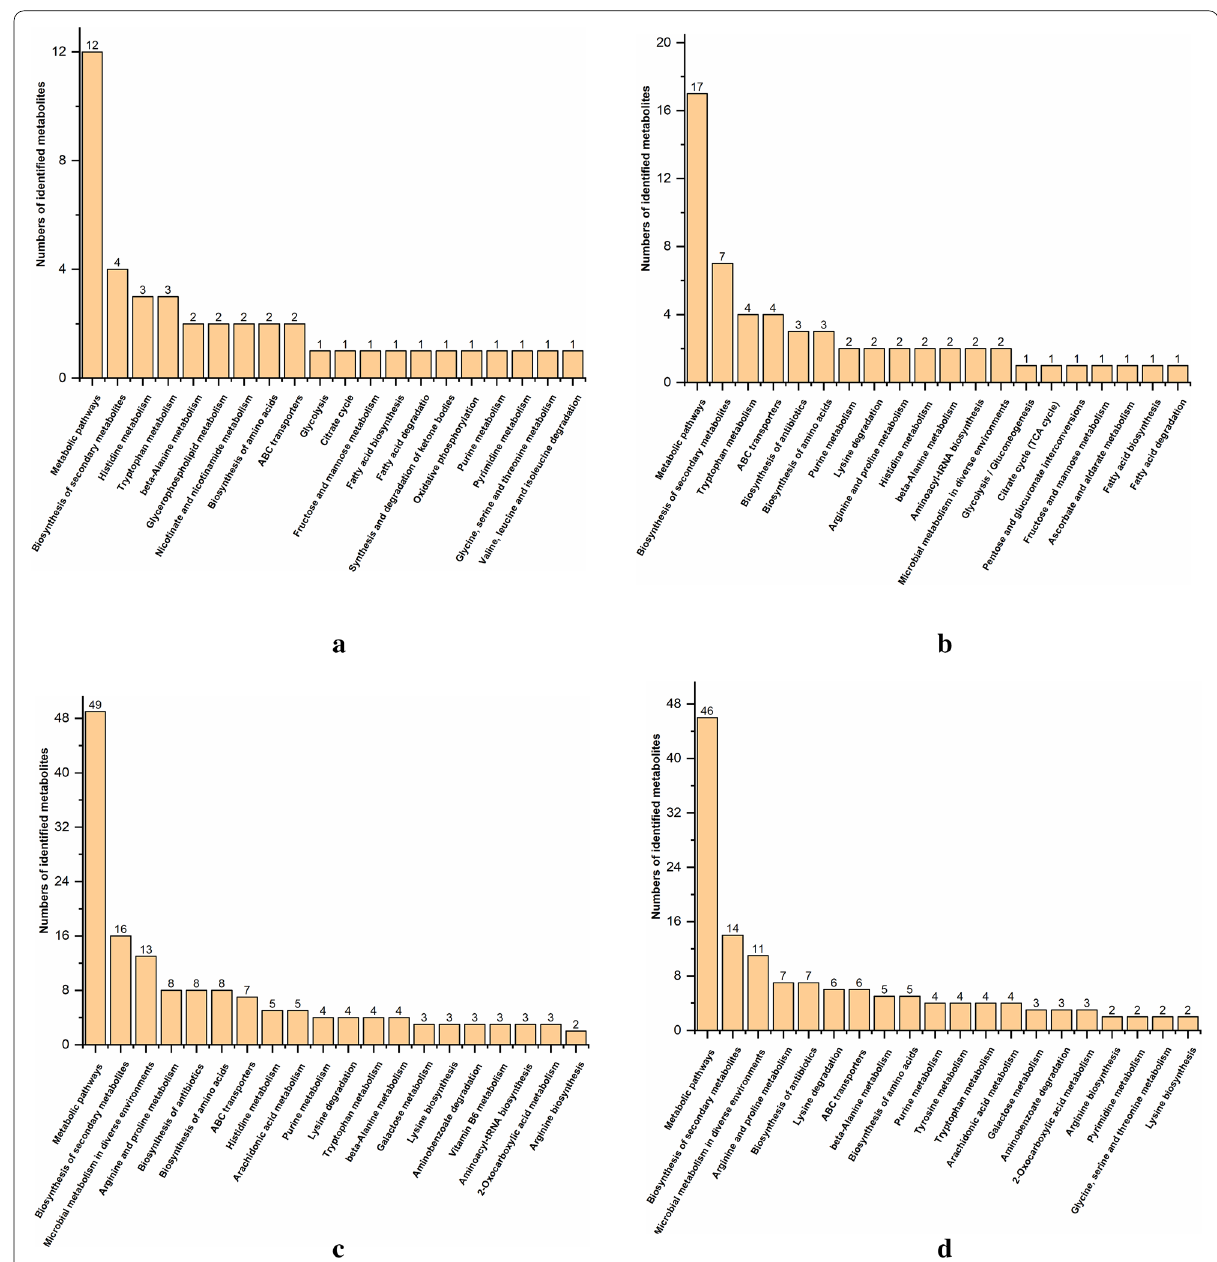
Fig. 6 Top 20 KEGG pathway for differential metabolites for group 1 vs 5 ( a ), 2 vs 6 ( b ), 3 vs 5 ( c ), and 4 vs 6 ( d